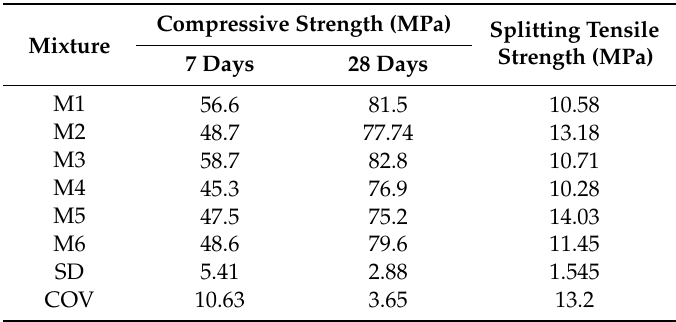
Table 2. Compressive strength and splitting tensile strength test results.